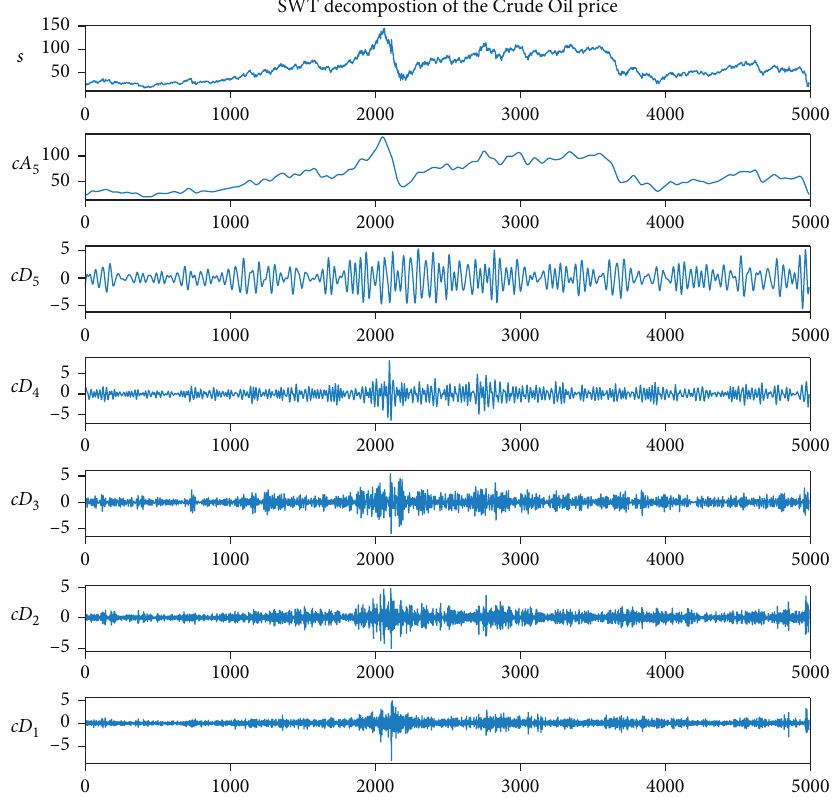
i : approximation coefficients at decomposition